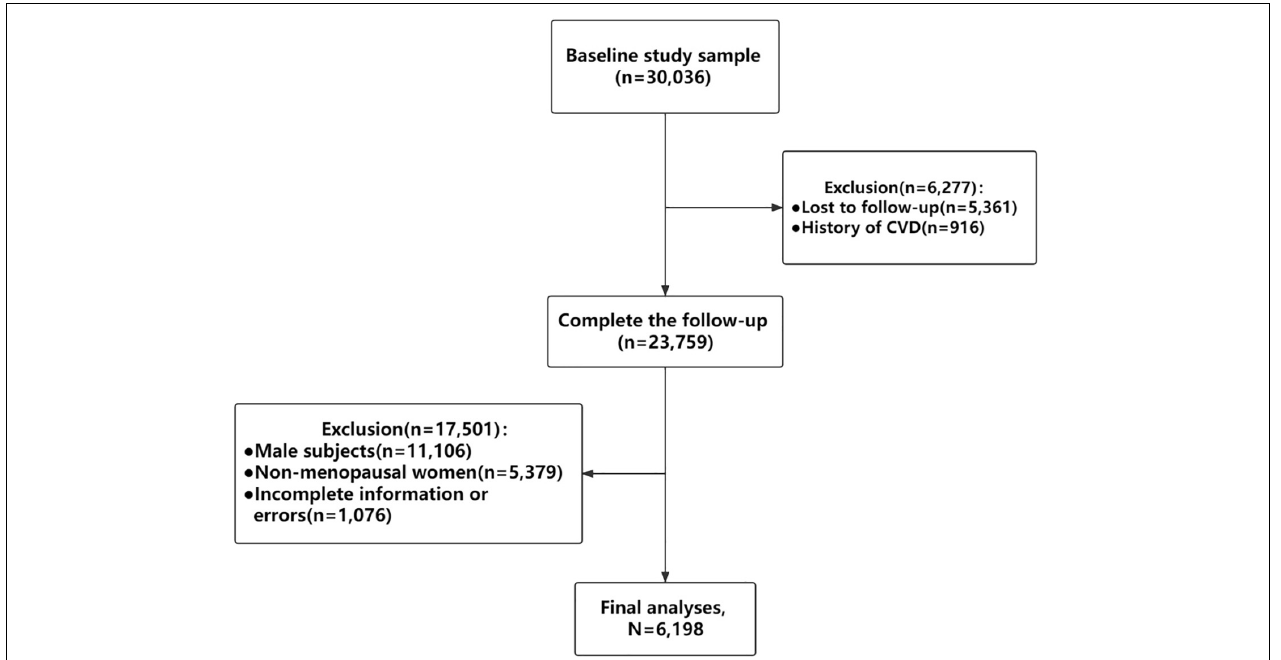
FIGURE 1 | Flowchart of inclusion and exclusion of study participants. CVD, cardiovascular